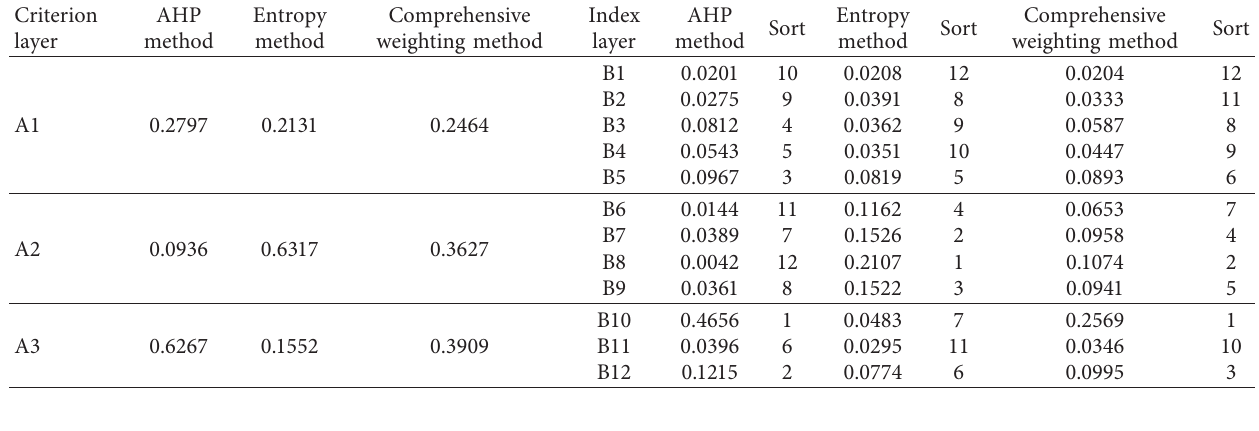
Table 3: Weights and rankings for different indicators.